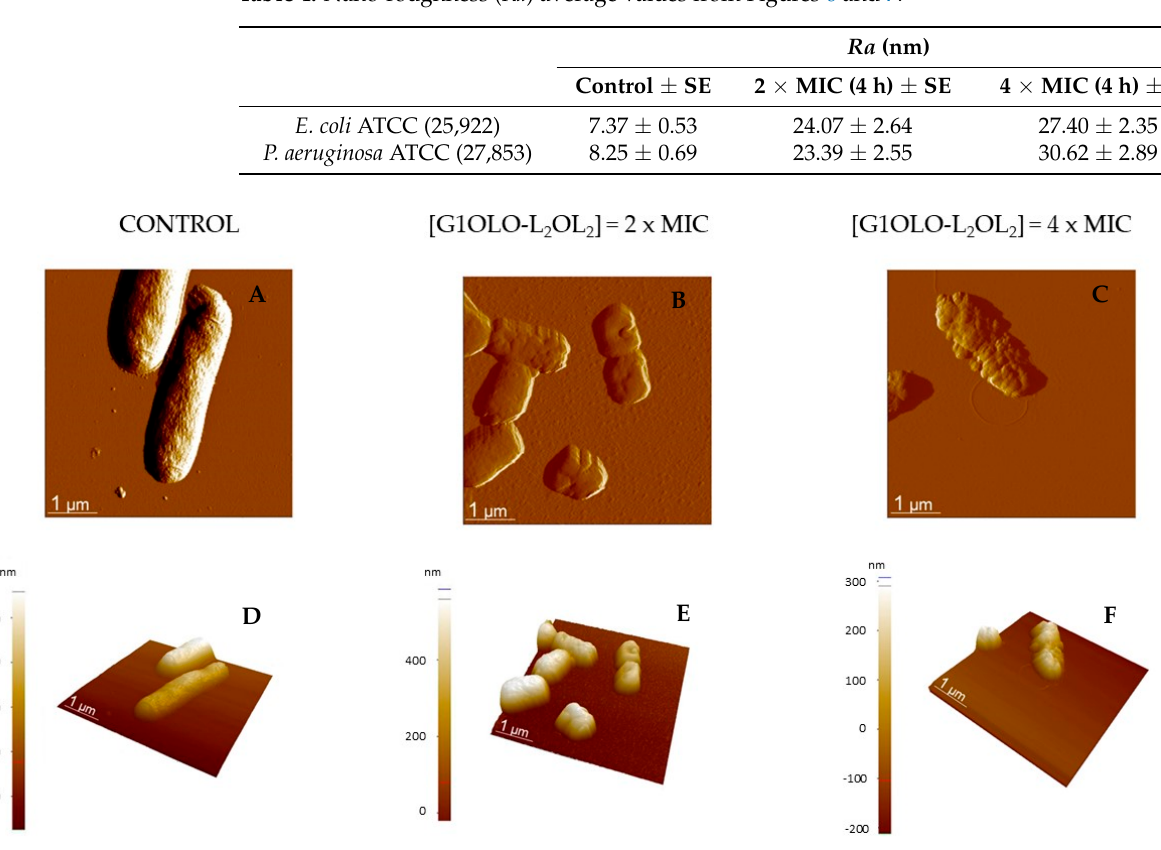
Figure 7. AFM amplitude ( A – C ) and 3D topographic ( D – F ) images of E. coli (ATCC 25,922) incubated with different concentrations of G1OLO-L 2 OL 2 .